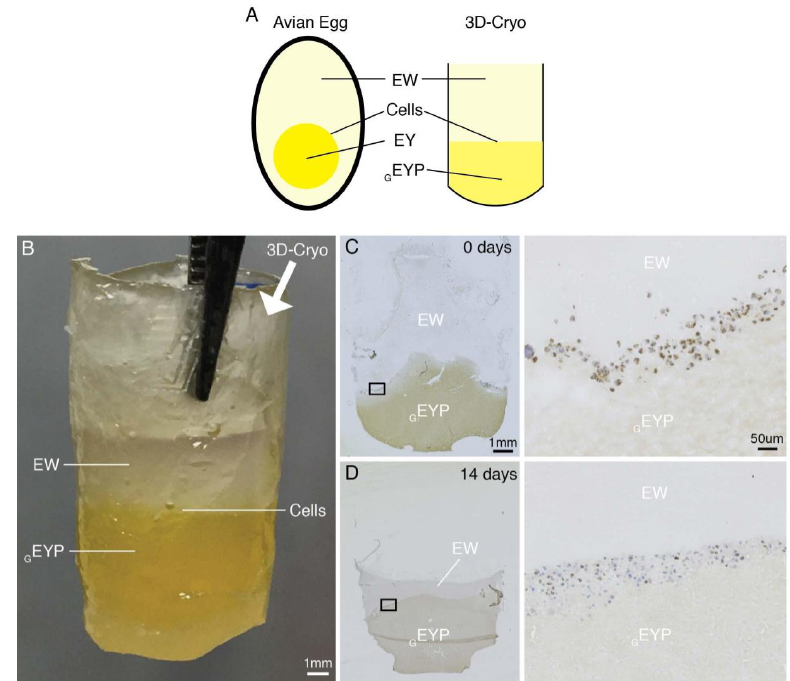
Figure 4. Proof of concept for G EYP + EW human in vitro model with 3D-Cryo well insert. ( A ) Planning of G EYP + EW experiment similar to the EY and EW interface around cells in avian development; ( B ) Picture of the well insert with both visible layers, G EYP and EW from the exterior; ( C ) T = 0: Sagittal section of 3D-Cryo well insert stained by IHC with anti-Ki-67 antibody. NS-SV-AC cells at the interface between G EYP and EW; ( D ) T = 14 days: Sagittal section of 3D-Cryo well insert stained by IHC with anti-Ki-67 antibody. NS-SV-AC cells at the interface between G EYP and EW. With panel ( C,D ), left pane is a general overview of the sagittal section at 25× and black box is the location of 200× magnigifcation on right. DAB stained Ki-67 positive cells are brown, and hematoxylin stained nuclei blue.